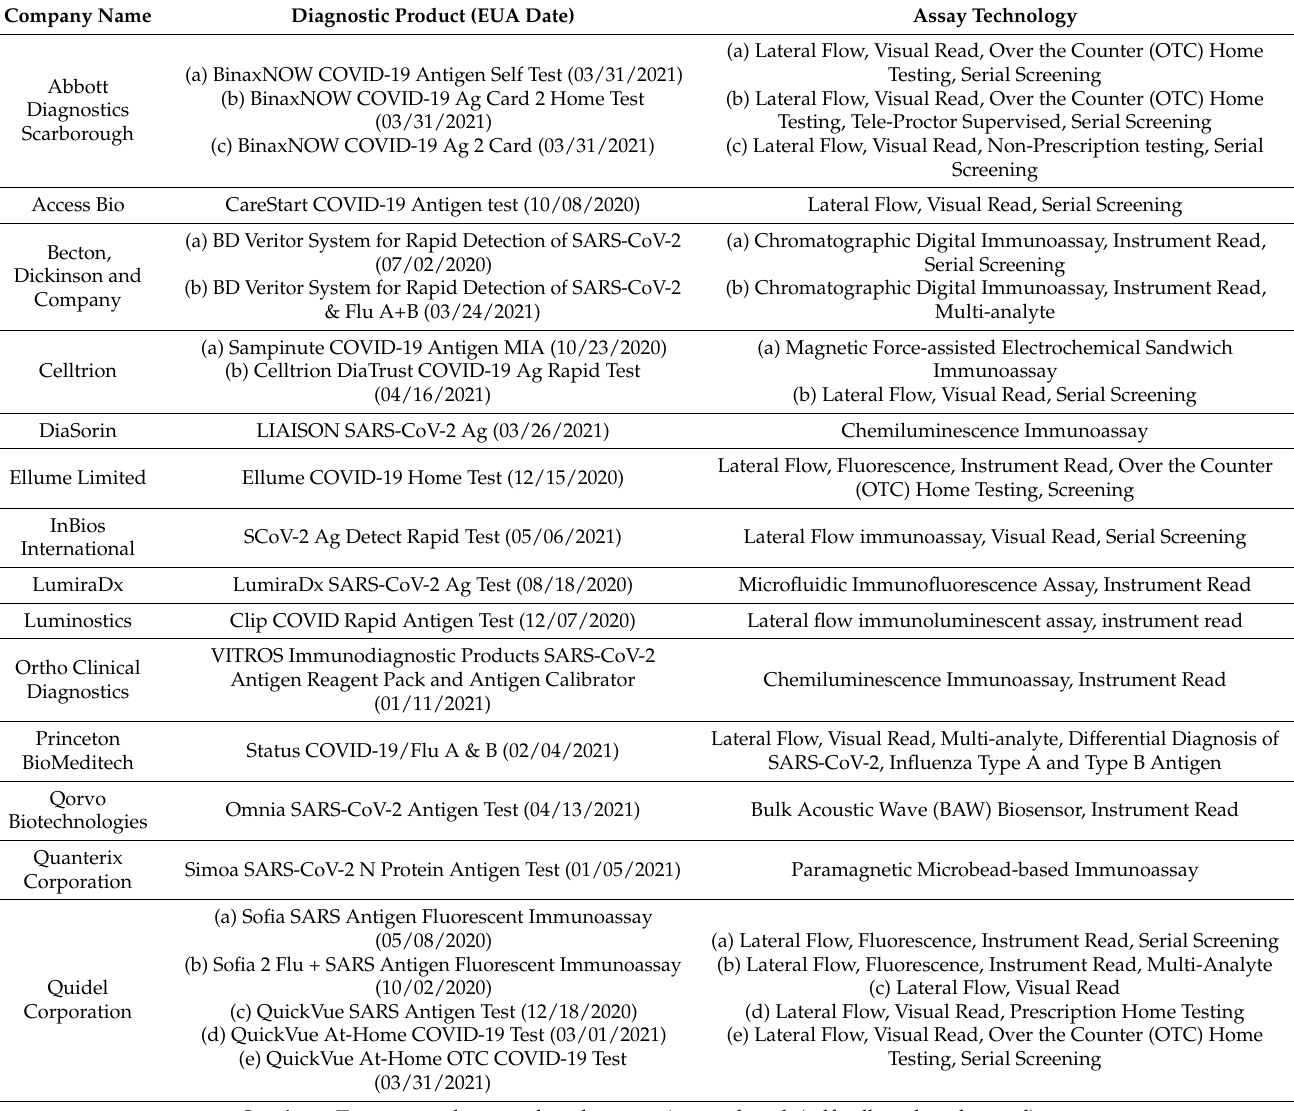
Table 3. Rapid Antigen Diagnostic Tests granted FDA Emergency Use